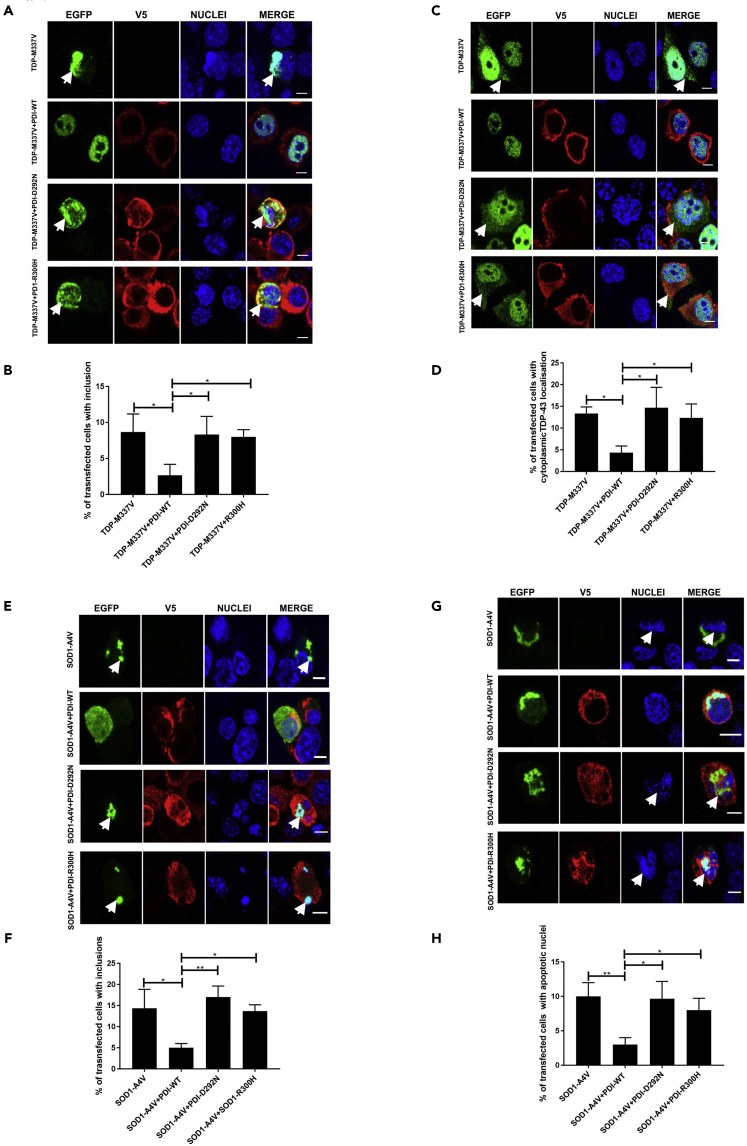
ALS-Linked PDI Mutants (D292N and R300H) Are Not Protective against Mutant TDP-43 and Mutant SOD1(A) Cells expressing TDP-M337V with empty vector alone (row 1) or co-expressing PDI-WT, PDI-D292N or PDI-R300H (rows 2, 3, 4).(B) Significantly fewer cells formed inclusions when PDI-WT was co-expressed with TDP-M337V (∗p < 0.05) compared with PDI-D292N and PDI-R300H (∗p < 0.05).(C) Cells expressing EGFP-tagged TDP-M337V (row 1), or co-expressing PDI-WT, PDI-D292N or PDI-R300H (rows 2, 3, 4).(D) Co-expression of PDI-WT (∗p < 0.05) with mutant TDP-M337V significantly reduced the proportion of cells with cytoplasmic TDP-43 expression compared with those co-expressing PDI-D292N or PDI-R300H (∗p < 0.05).(E) Cells expressing SOD1-A4V (row 1) or co-expressing PDI-WT, PDI-D292N or PDI-R300H (rows 2, 3, 4).(F) Significantly fewer cells with inclusions were observed when PDI-WT was co-expressed with SOD1-A4V (∗p < 0.05) compared with either PDI D292N (∗∗p < 0.01) or PDI R300H (∗p < 0.01).(G) Neuro-2a cells expressing SOD1-A4V (row 1) or co-expressing PDI-WT, PDI-D292N or PDI-R300H (rows 2, 3, 4).(H) Over-expression of PDI-WT (∗∗p < 0.01) with SOD1-A4V resulted in significantly fewer cells with apoptotic nuclei compared with those expressing empty vector and those co-expressing PDI-D292N or PDI-R300H (∗p < 0.05).Scale bars: 6 μm in (A), (C), (E), and (G).